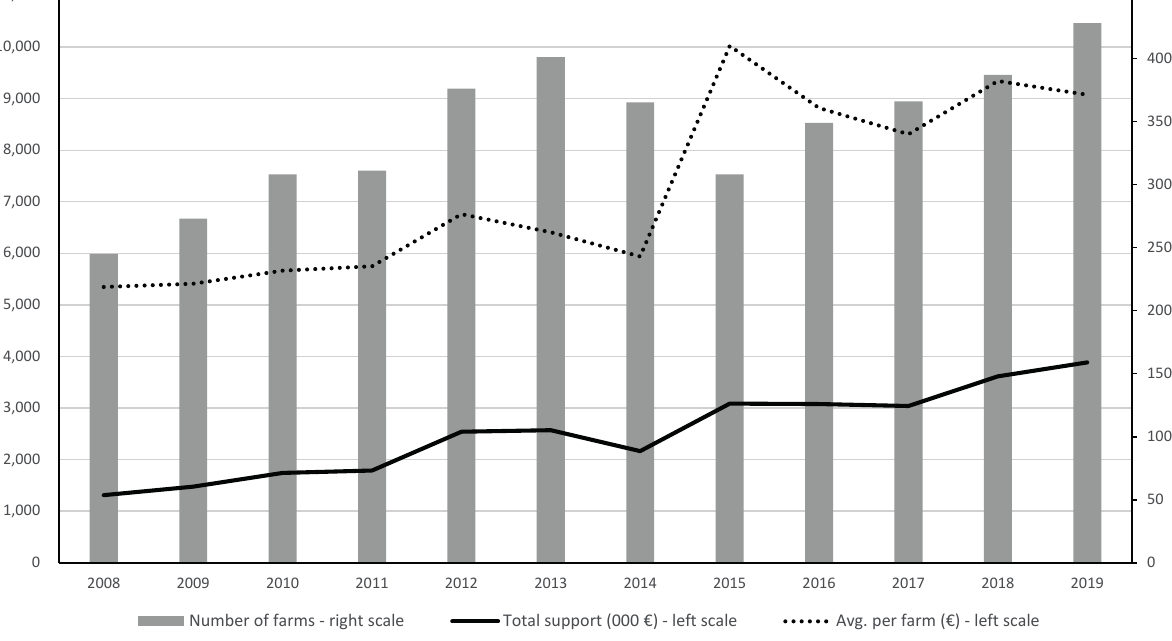
Figure A1. Evolution of the Agro-Environmental Measures (AEM) support within the Italian 2008-2019 FADN balanced sample: number of beneficiaries, total support and average support per